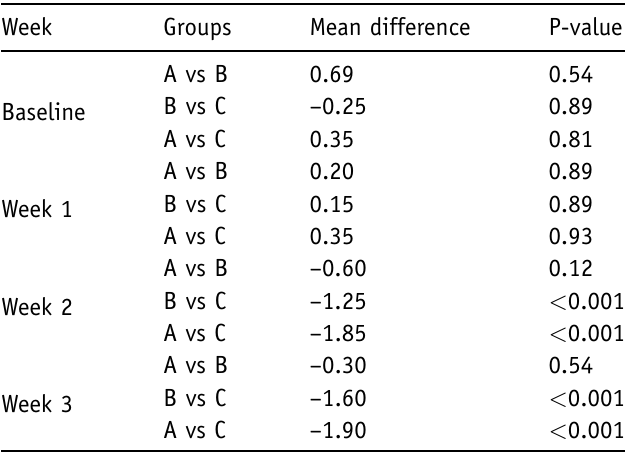
Table II. Comparison of mean difference in pain scores between groups (post-hoc